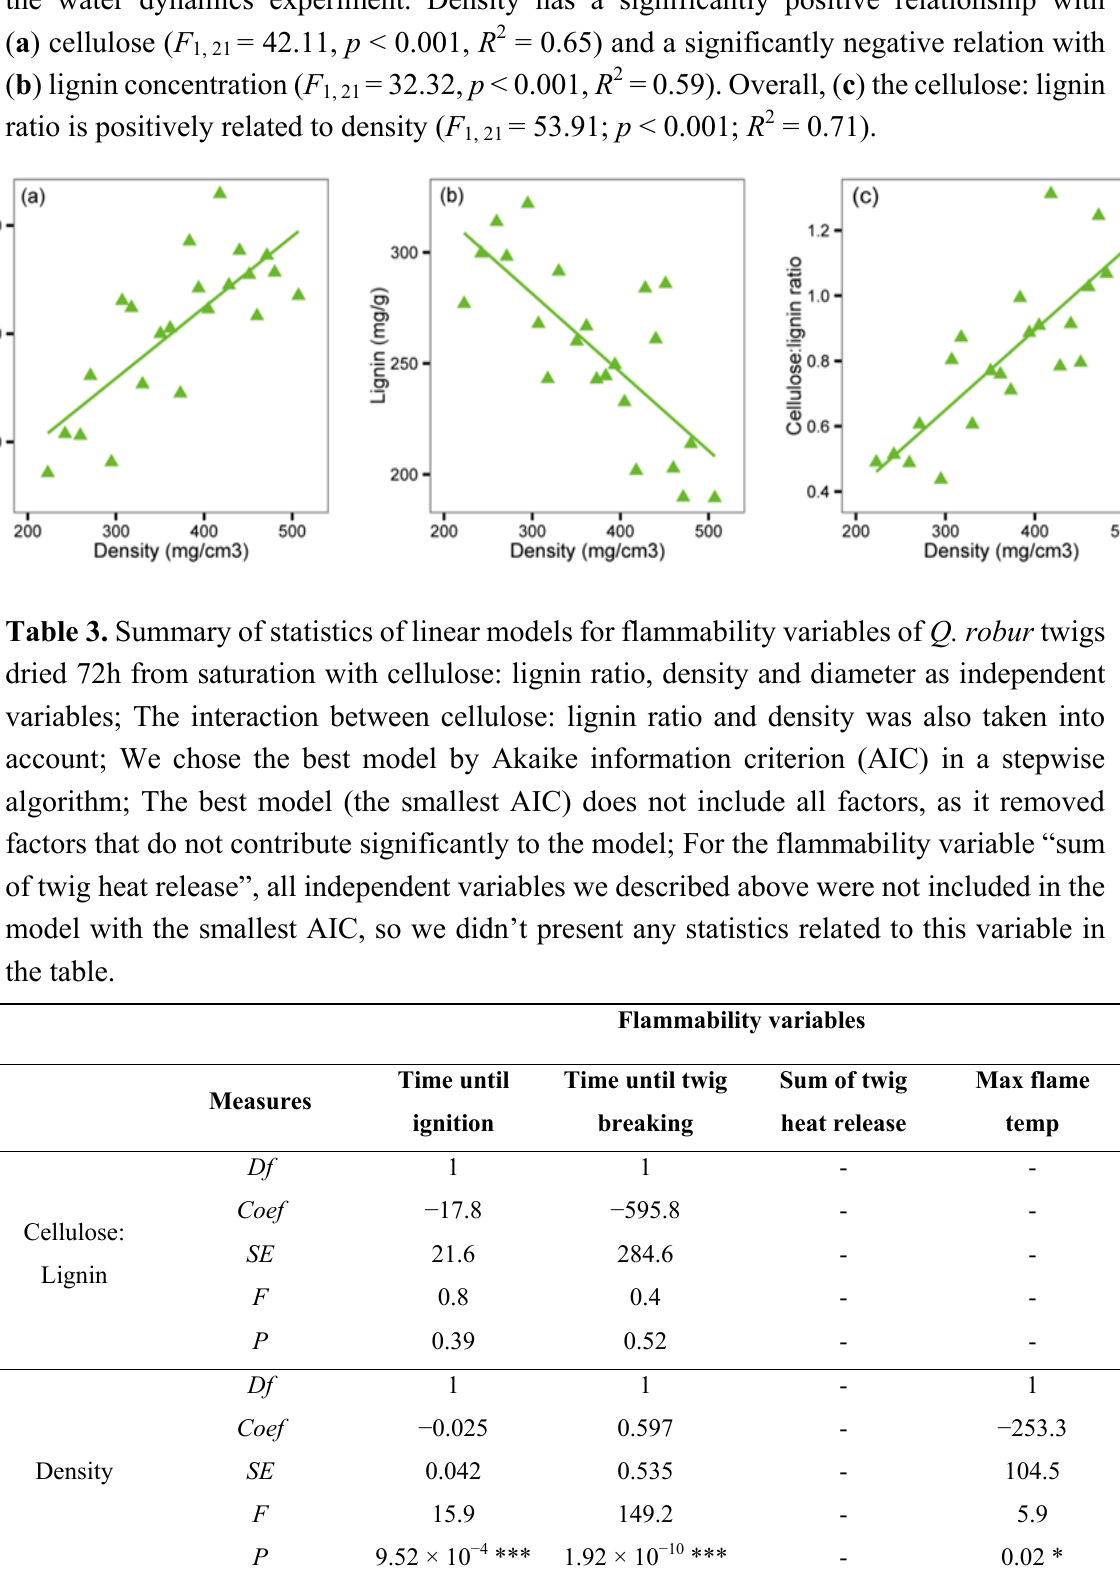
Figure 6. Chemical properties of Quercus robur twigs selected from the 72 h treatment in the water dynamics experiment. Density has a significantly positive relationship with